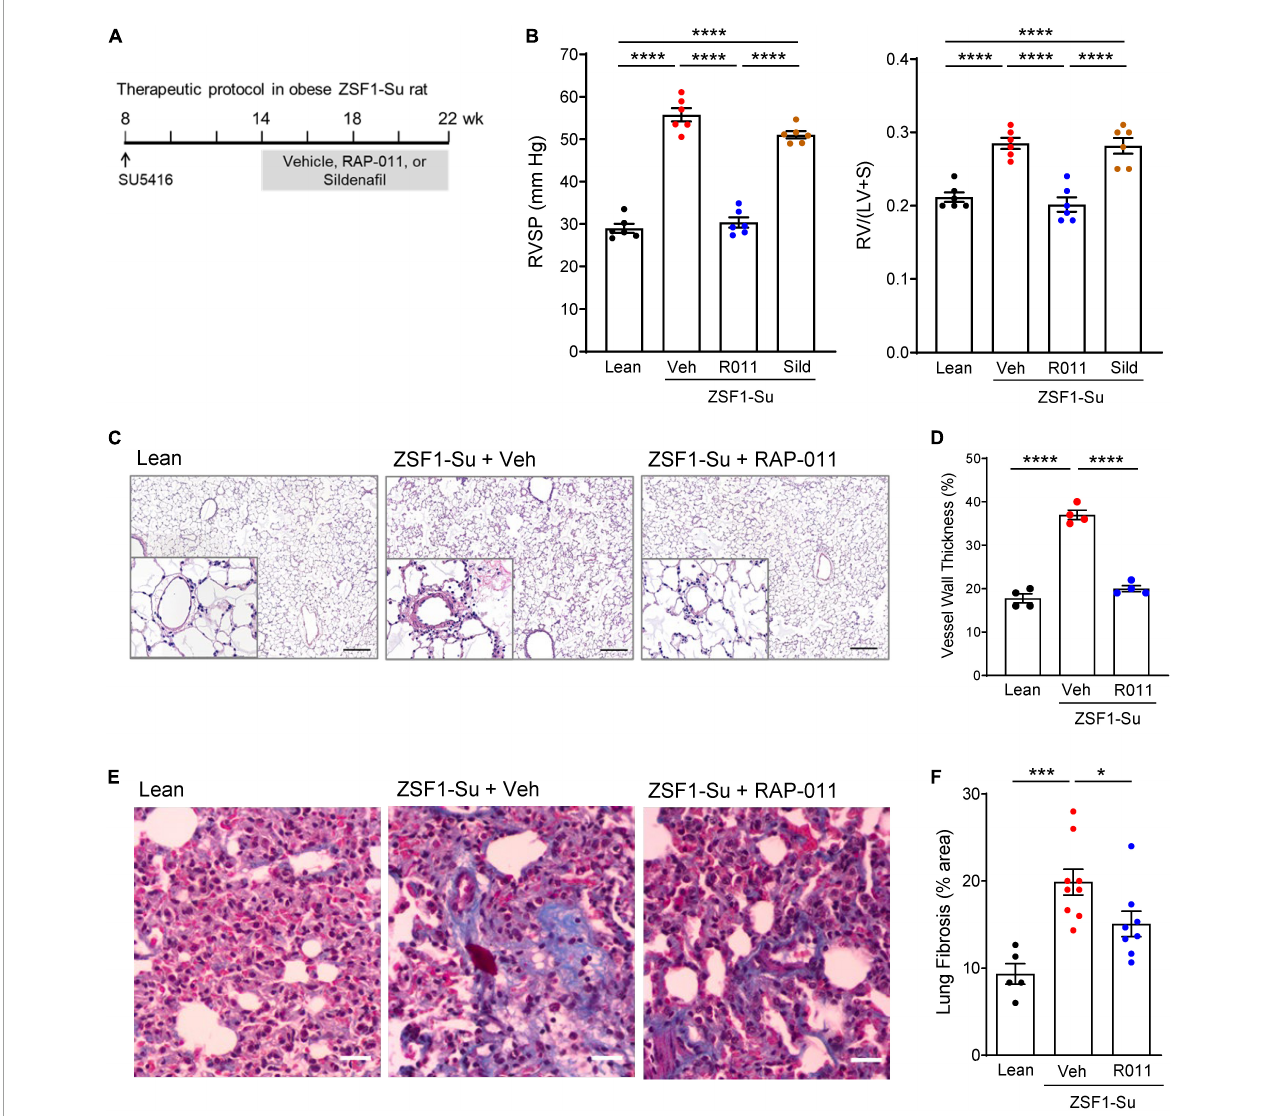
FIGURE4 Therapeutic treatment with ActRIIA-Fc improves pulmonary remodeling and cardiopulmonary function in the obese ZSF1-Su rat model of PH-HFpEF. (A) Experimental approach used to evaluate therapeutic effects of ActRIIA-Fc (RAP-011, R011) in an obese ZSF1-Su rat model of PH-HFpEF. Rats were treated at 8 weeks of age with a single dose of SU5416 (100 mg/kg, s.c). After allowing 6 weeks for development of PH, rats were treated with RAP-011 (10 mg/kg, s.c., twice weekly), sildenafil (30 mg/kg, p.o., twice daily), or vehicle (Veh, PBS) for 8 weeks. (B) Effects of RAP-011 (R011) or sildenafil (Sild) on RV systolic pressure (RVSP) and Fulton index [RV/(LV + S)], a measure of RV hypertrophy. (C) Images of representative lung sections stained with hematoxylin and eosin, with insets showing degree of vascular remodeling. Scale bar, 200 µ m. (D) Vessel wall thickness as a percentage of vessel outer diameter. (E) Images of lung sections stained with Masson’s trichrome to detect fibrosis. Scale bar, 50 µ m. (F) Quantification of fibrotic tissue area. Data are means ± SEM. Analysis by one-way ANOVA and Tukey’s (B) or Dunnett’s (D, F) post-hoc test. * P < 0.05; *** P < 0.001; **** P < 0.0001. Lean, lean control